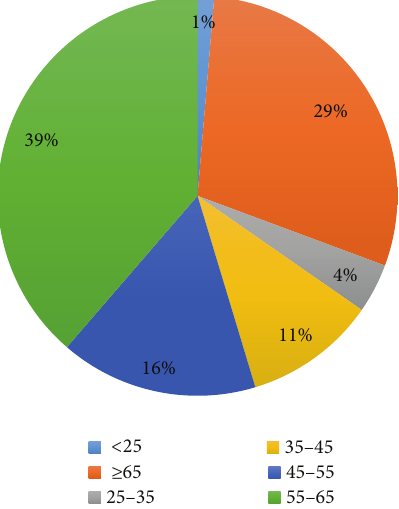
Figure 1: Age group of e-bike riders in the e-bike fatal